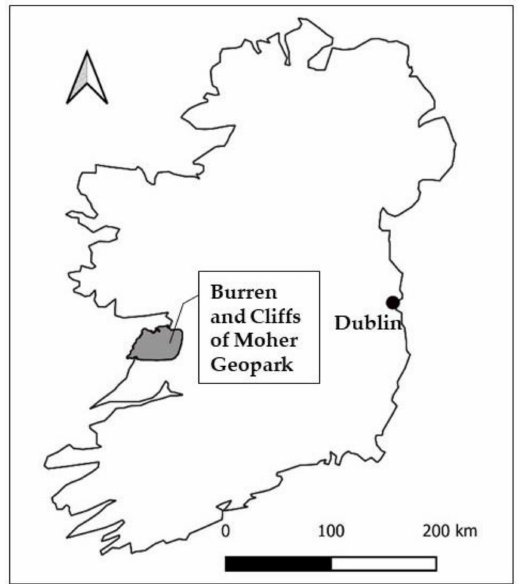
Figure 1. Burren and Cliffs of Moher Geopark in